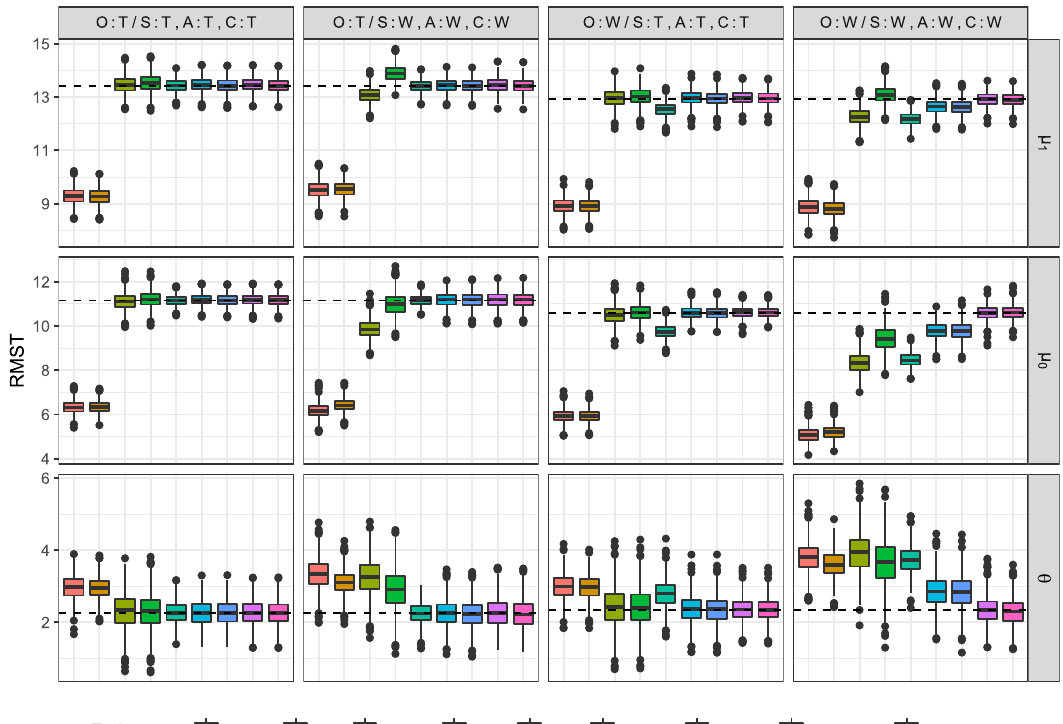
Figure 2: Boxplot of estimators under four model speci fi cation scenarios; T: true ( correct ) model, W: wrong ( incorrect )